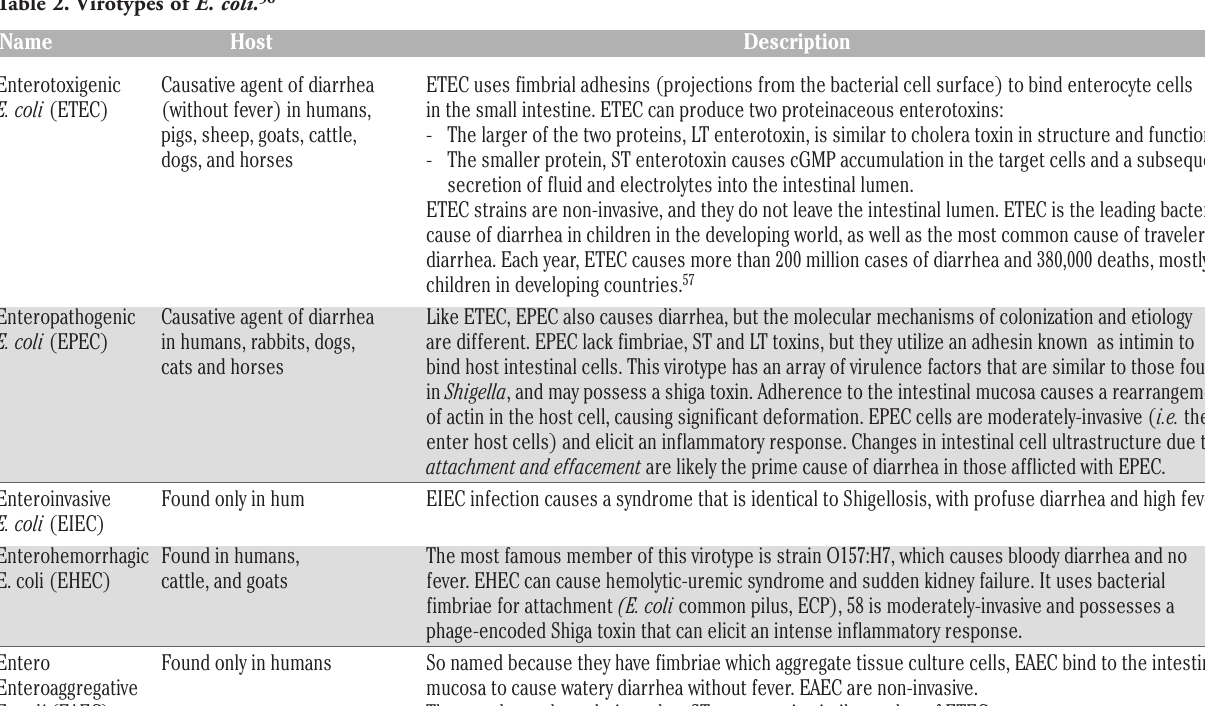
Table 2. Virotypes of E. coli.